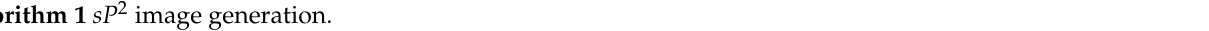
Algorithm 1 sP 2 image generation.